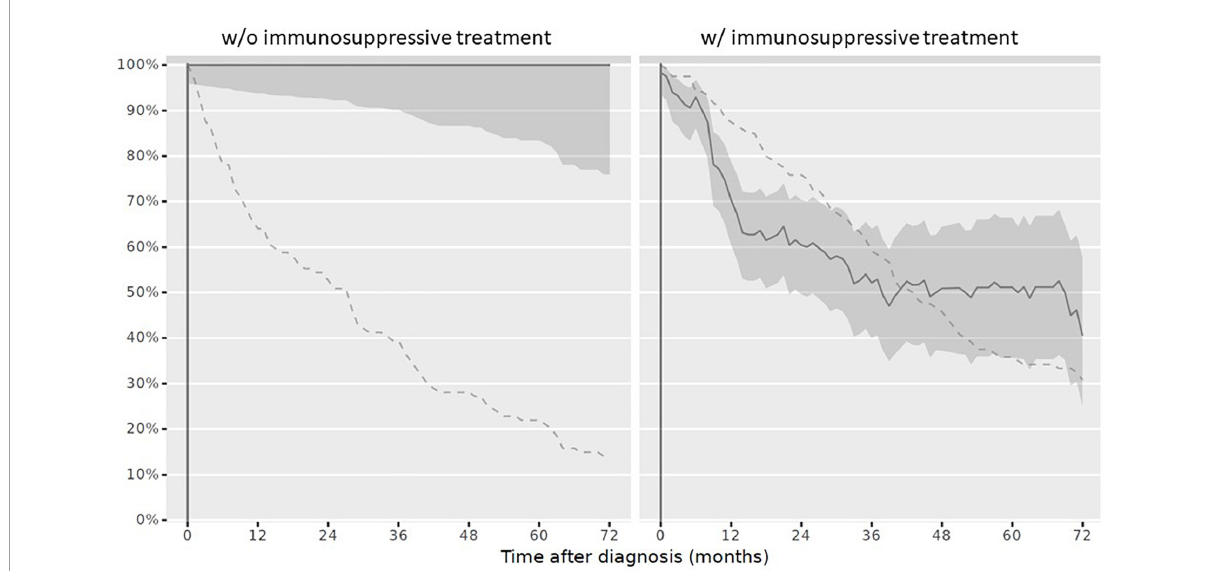
FIGURE5 Complete vaccination status against influenza in children after PRD diagnosis. Legend: y-axis Completeness (% patients vaccinated completely, solid line with 95% confidence interval); x-axis Sample size (% patients available, dashed line). PRD, pediatric patients with rheumatic disease. w/o, without immunosuppressive treatment, w/ with immunosuppressive treatment.